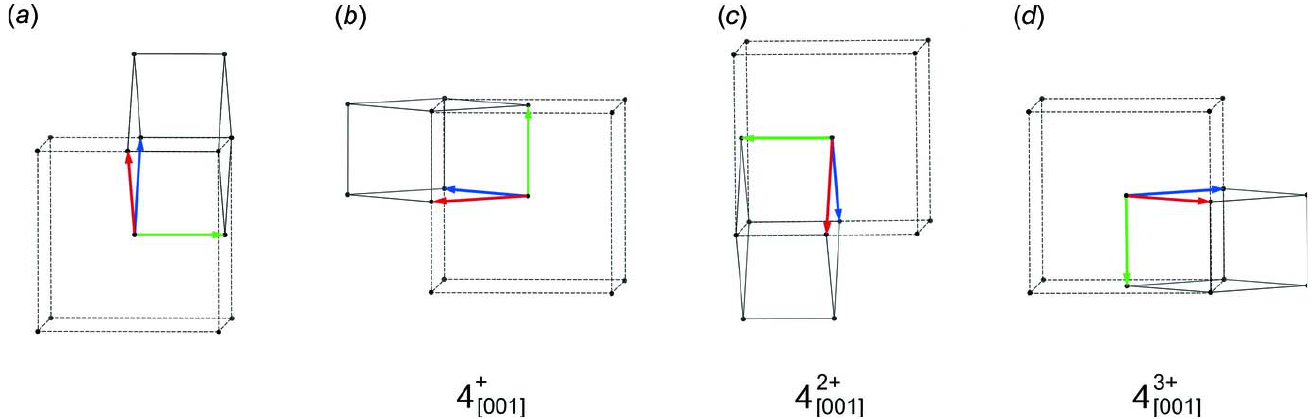
Figure 13 ( a ) Relationship between the pseudo-tetragonal I -centred supercell (dashed lines) and a primitive monoclinic individual (solid black lines, plus red = a , green = b , blue = c ) of the twin in SAXDUR, viewed slightly off the fourfold twin axis, and after anticlockwise rotations of ( b ) 90 (cid:3) , ( c ) 180 (cid:3) , and ( d ) 270 (cid:3) about the twin axis. Diagrams generated using VESTA (Momma & Izumi, 2011).